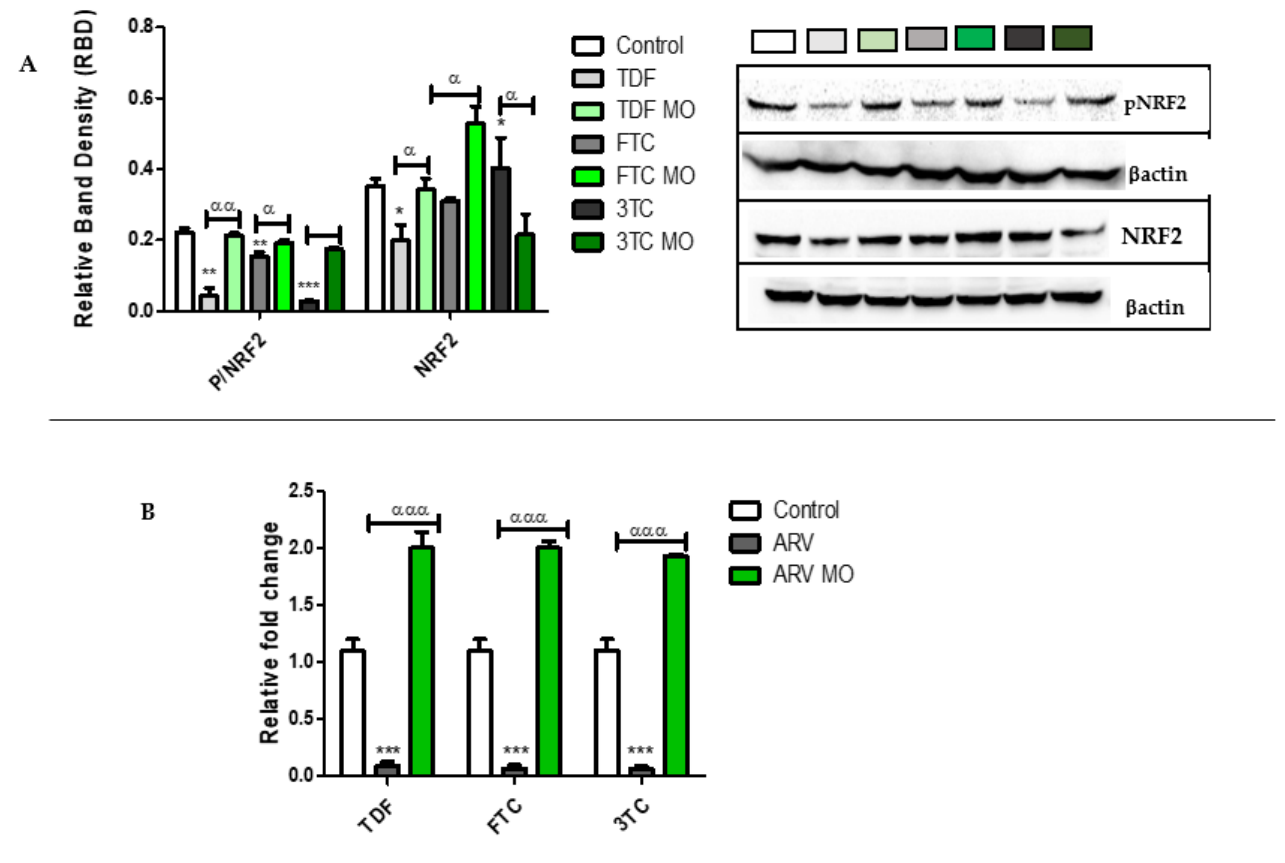
Figure 5. Assessment of pNRF2 and NRF2 expression post-ARV and post-ARV MO treatment. ( A ) TDF, FTC, and 3TC significantly decreased the levels of pNRF2, TDF and 3TC significantly decreased the expression of NRF2, while 3TC caused a slight increase in NRF2 expression. MO increased pNRF2 and NRF2 in ARVs treatments with a slight decrease at 3TC. ( B ) The NRF2 mRNA was significantly decreased by TDF, FTC, and 3TC while significantly increased by ARV MO. * Represents a significant difference between the control and ARV (*, p < 0.05, **, p < 0.001 and ***, p < 0.0001). α Represents a significant difference between ARV and ARV MO ( α , p < 0.05, αα , p < 0.001 and ααα , p < 0.0001).